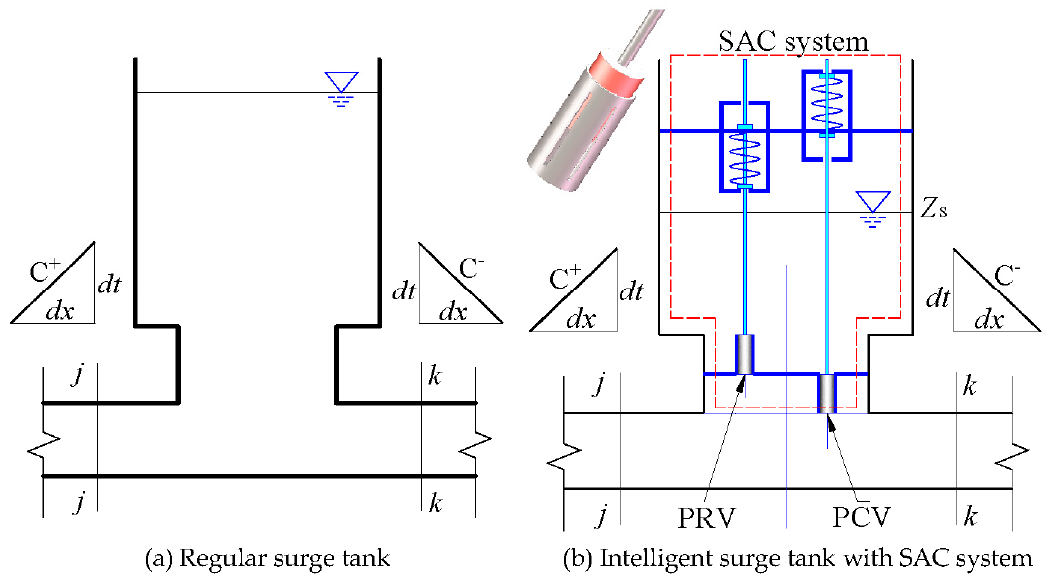
ff erent surge tank Figure 1. C omparison of different surge tank arrangements. Figure 1. Comparison of di